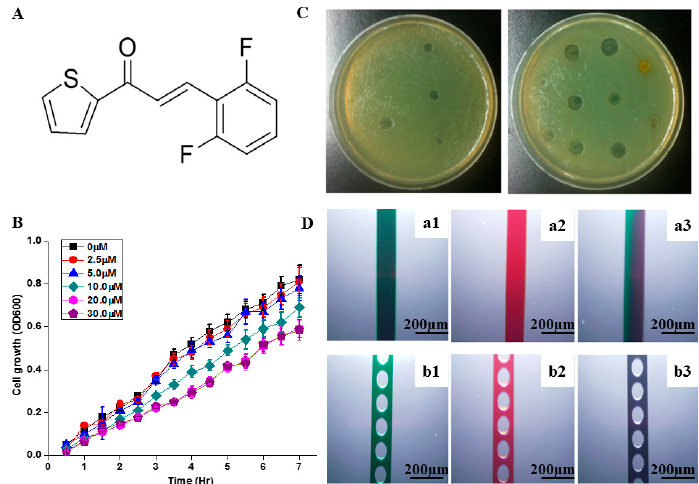
Figure 1. ( A ) Chemical structure of 1-(Thien-2-yl)-3-(2,6-difluoro phenyl) prop-2-en-1-one (1-TDPPO); ( B ) chemical response of the antimicrobial agents (20 µM of 1-TDPPO) at day 1 (left) and day 3 (right) in a Petri dish; ( C ) selection of the optimal concentrations for the antimicrobial effect with 1-TDPPO; and ( D ) comparison of mixing efficacy between without ( a1 – a3 )/with ( b1 – b3 ) circular obstacles using green and red dyes. Here a3 and b3 are images after mixing.